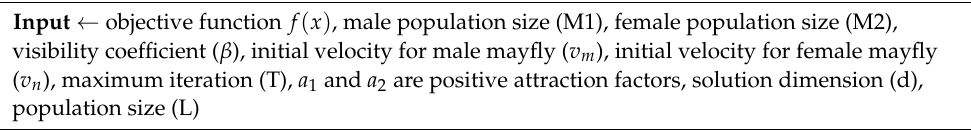
Algorithm 1: Mayfly optimization